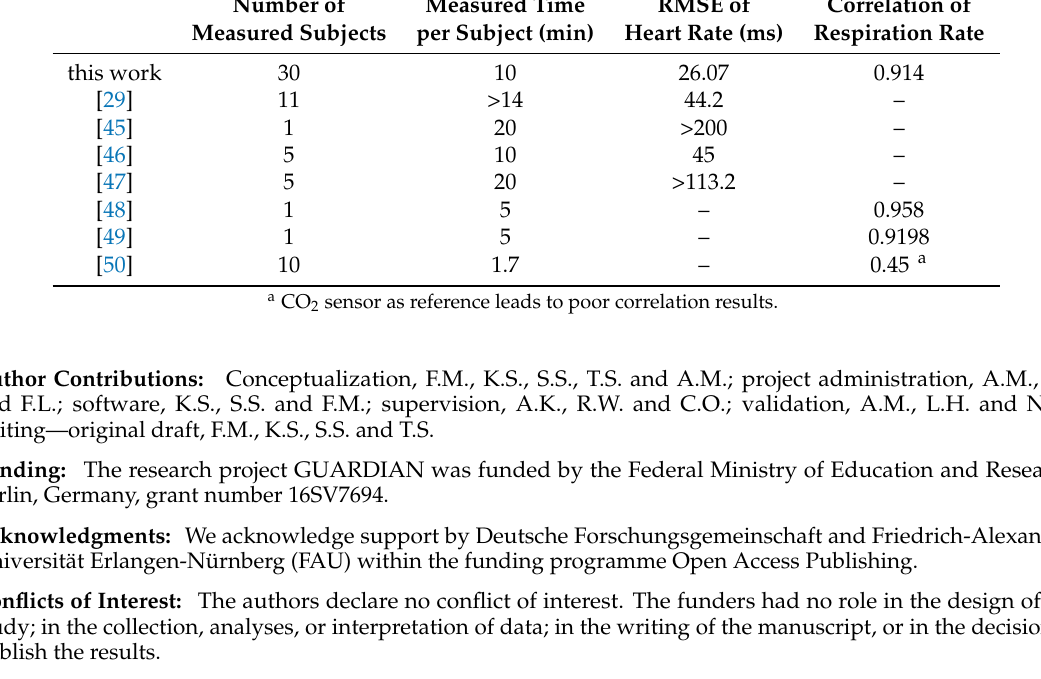
Table 4. Comparison of this work to the current state-of-the-art. Number of Measured Time RMSE of Correlation of Measured